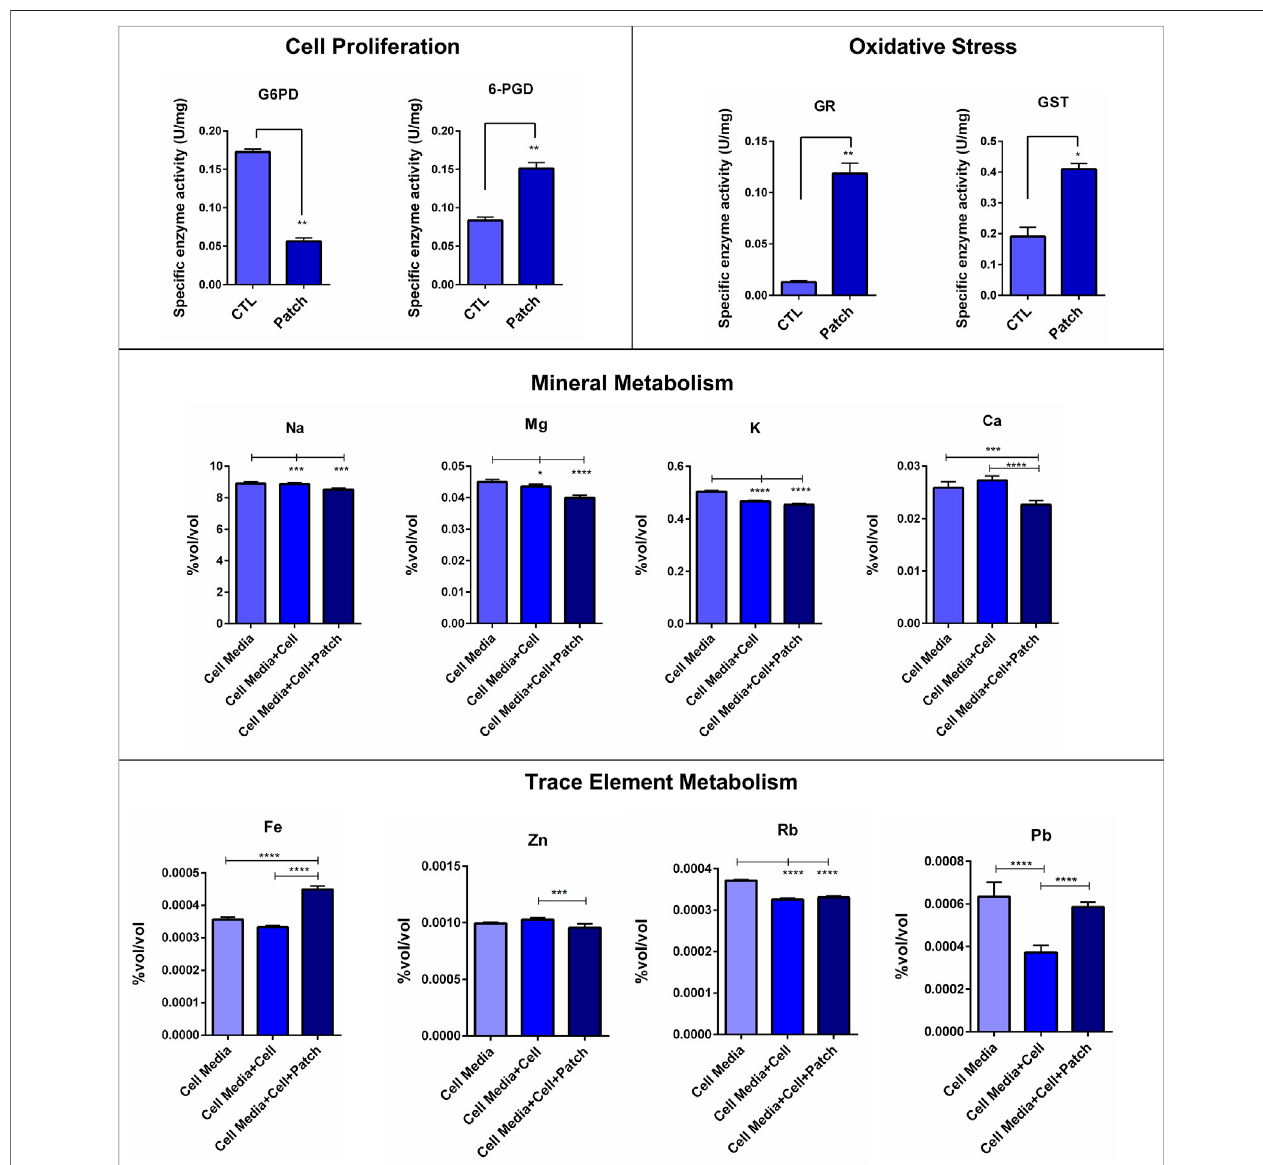
FIGURE2| EvaluationoftheproliferationandoxidativestressstatusofcellsgrowingonthedermalpatchviaG6PD,6PGD,GRandGSTenzymeactivitiesinvolving in the pentose phosphate pathway. Na, Mg, K, Ca, Fe, Cu, Sr, Zn, Rb and Pb levels in the cell media of the dermal patch with and without cells were evaluated via